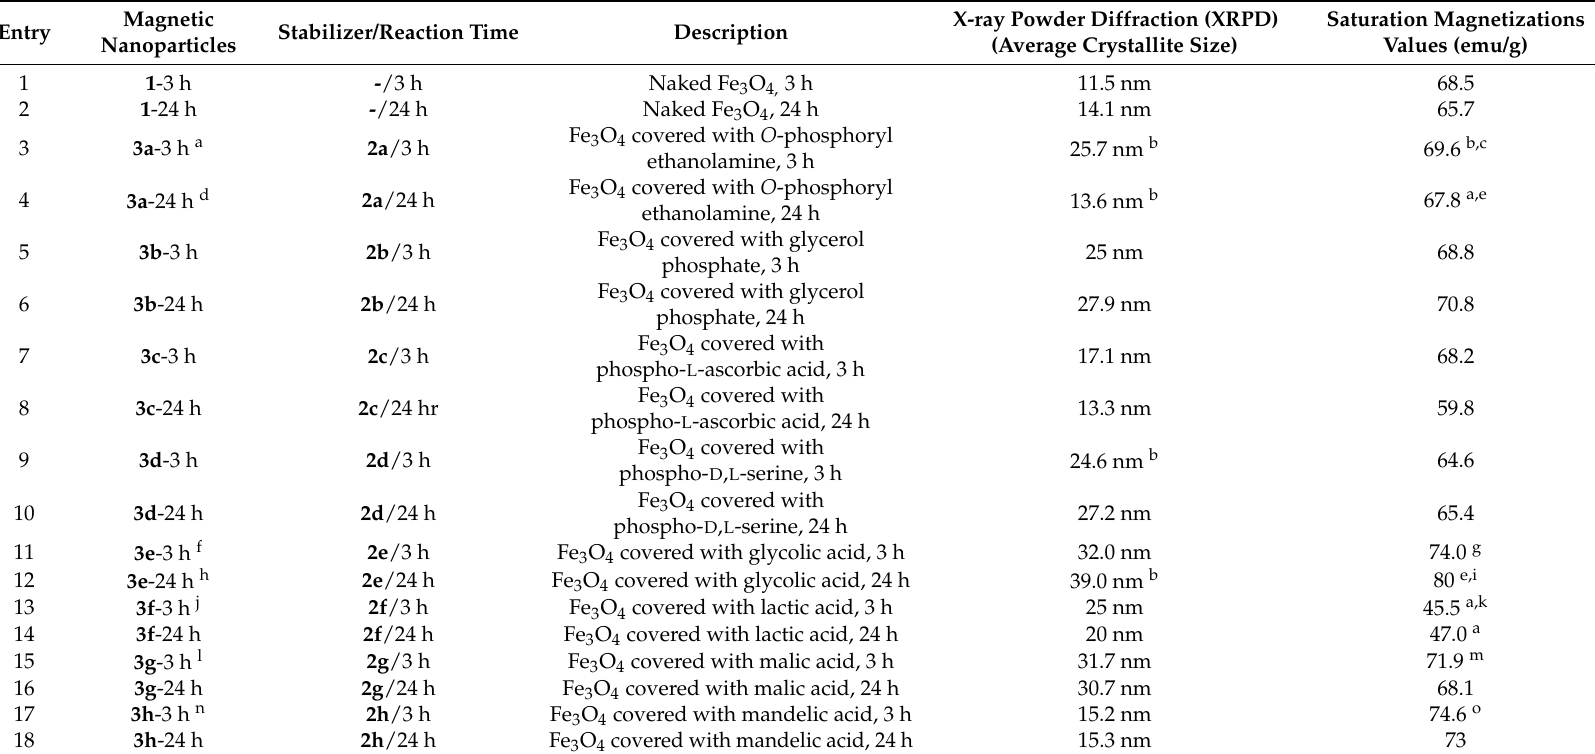
Table 1. Average crystallite sizes calculated with Scherrer equation and saturation magnetization of magnetic nanoparticles 1 and 3